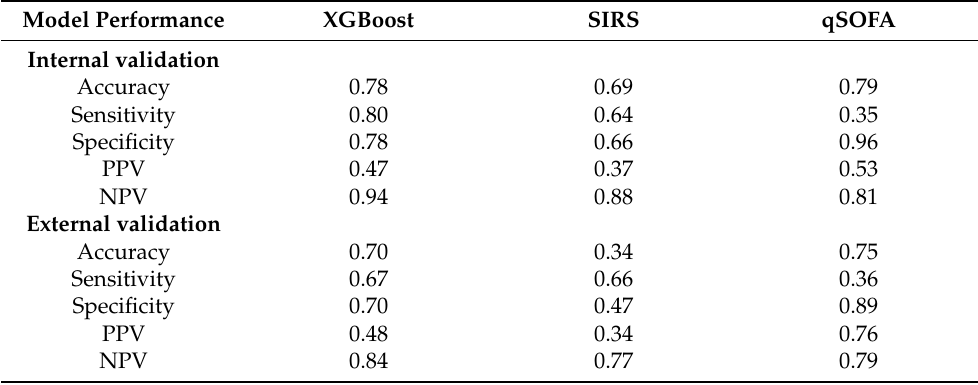
Table 3. Diagnostic performance of the identification of sepsis.